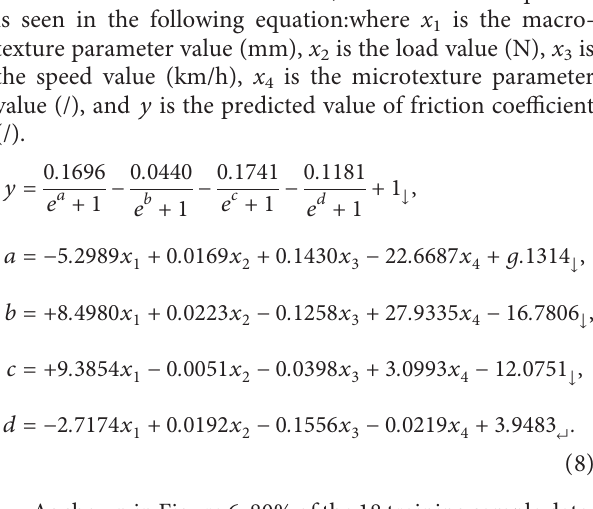
Table 8: Coefficients used for the predictive model of